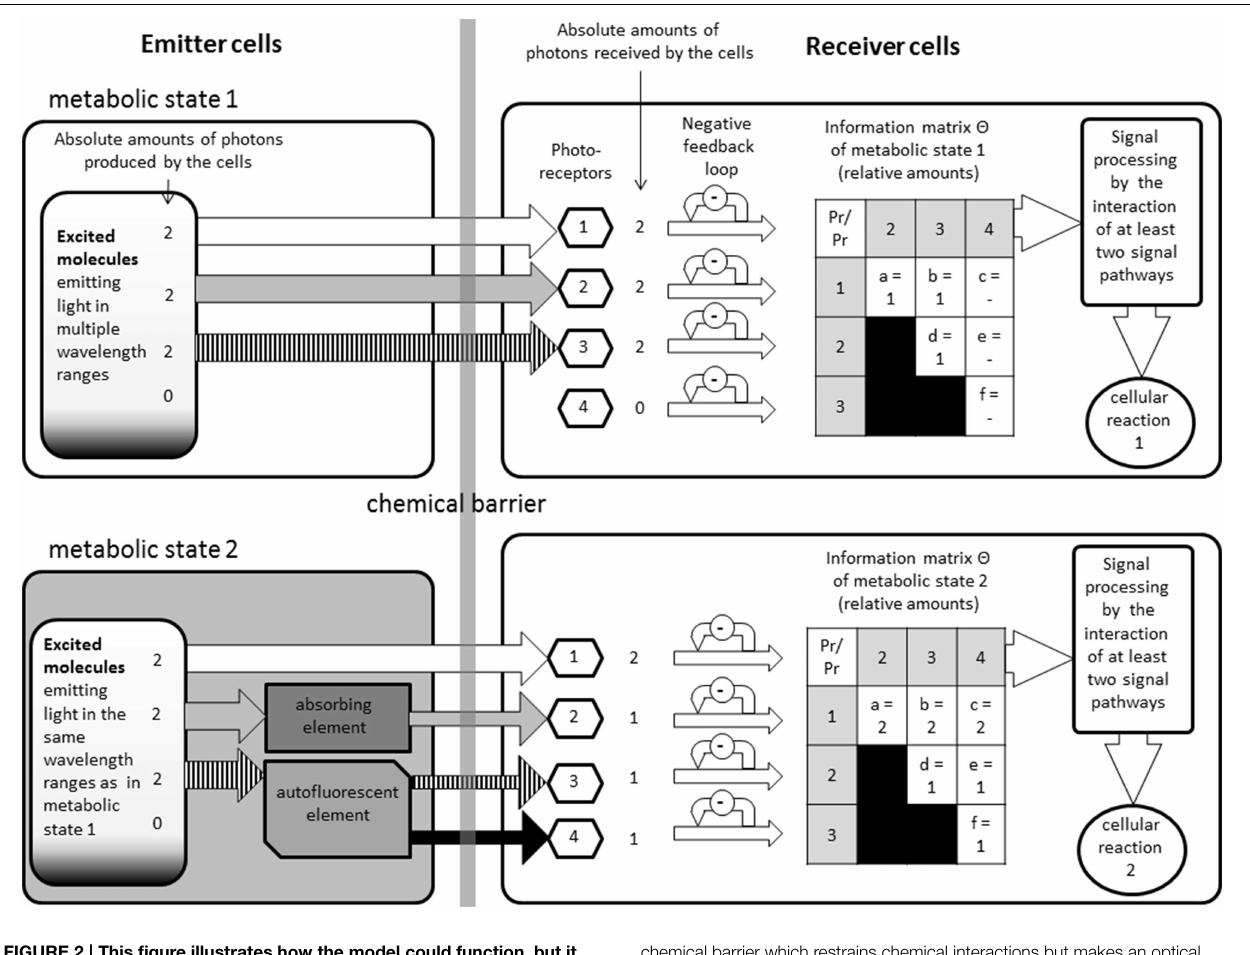
FIGURE 2 | This figure illustrates how the model could function, but it does not reflect any specific proteins or pathways. On the left side are the emitter cells in two different metabolic states. Depending on the state, different amounts of light will be able to escape the cells in different wavelengths. On the right are the receiver cells. In between there is a